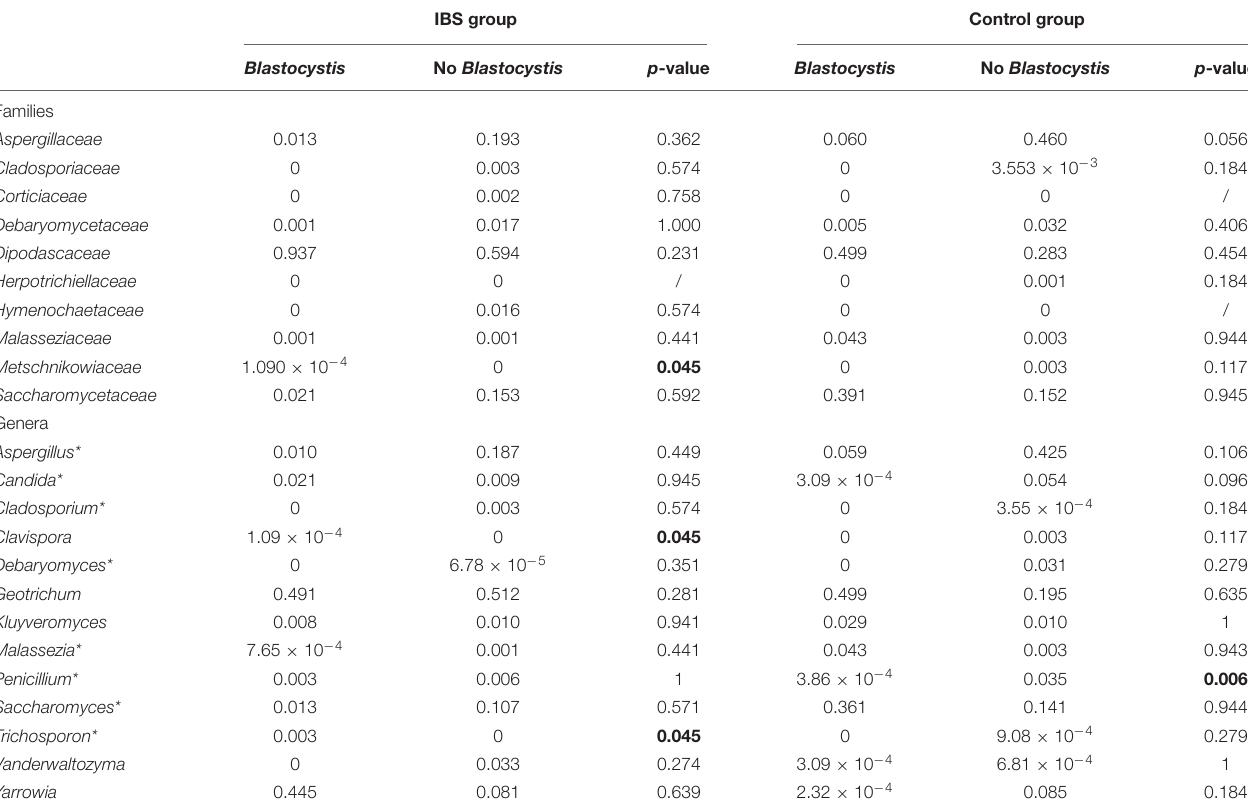
TABLE 2 | Relative abundances of the 10 most prevalent fungal families and the most commonly detected genera in gut mycobiome studies (core mycobiota) and in this